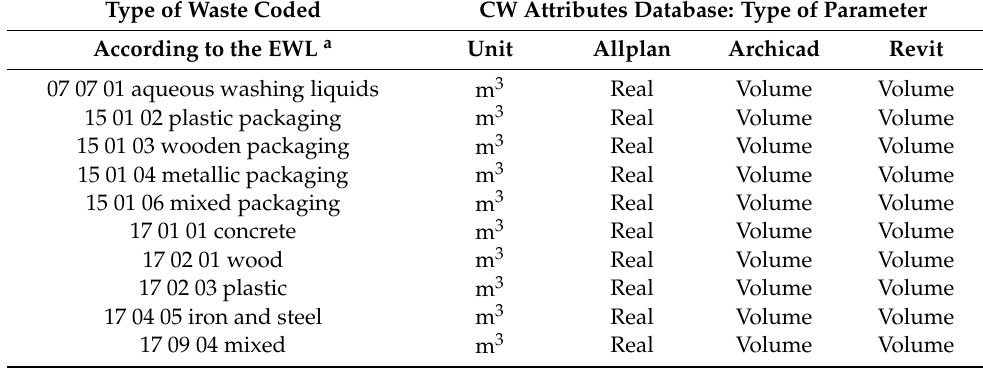
Table 1. Example of new CW attributes to enrich building elements in the BIM model adapted to the case